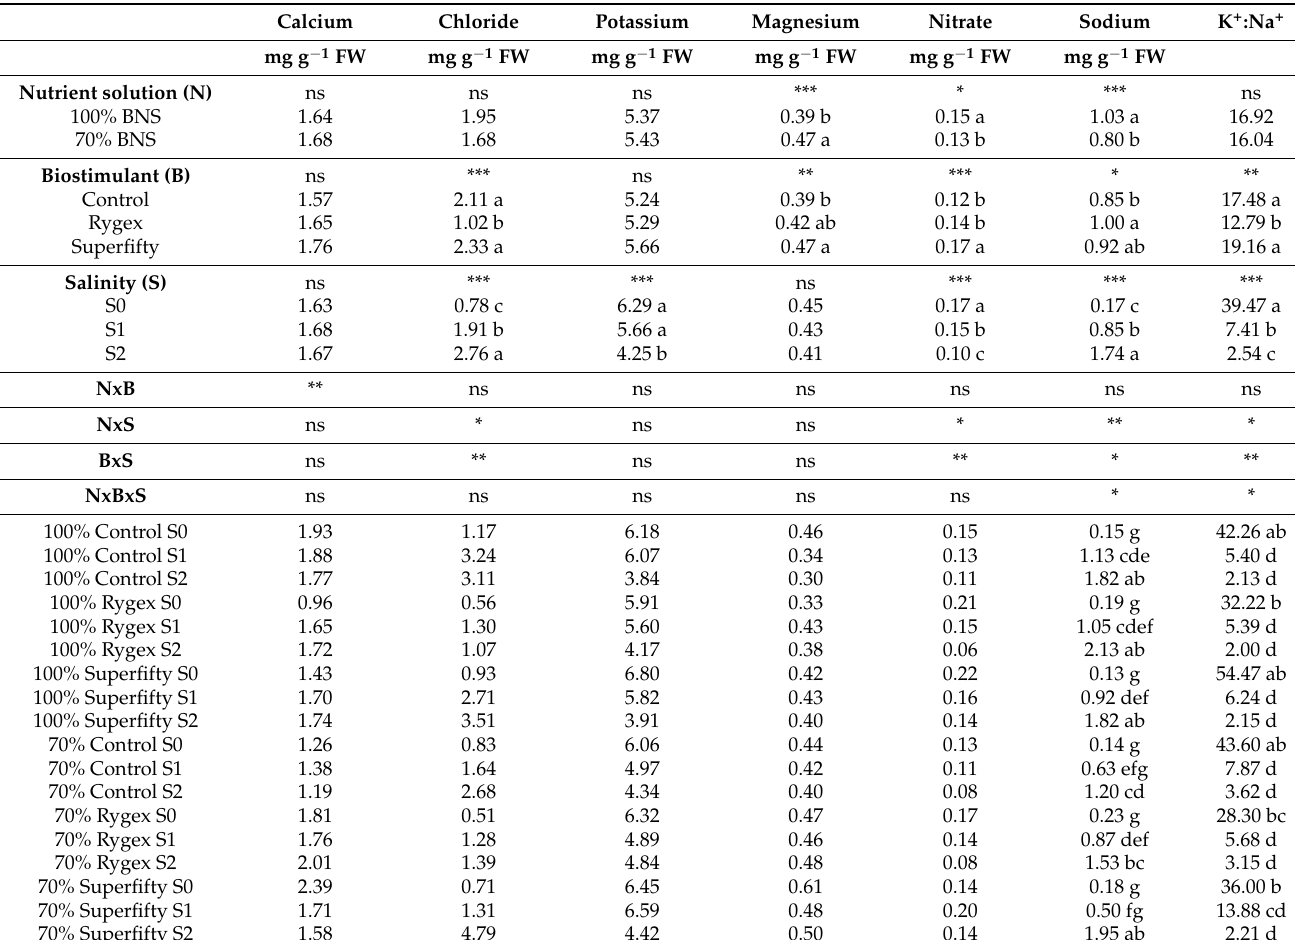
Table 2. Significance of the main factors (nutrient solution, biostimulant and salinity) and their interactions on ions content in leaves of MicroTom plants. Experimental design is as in Table